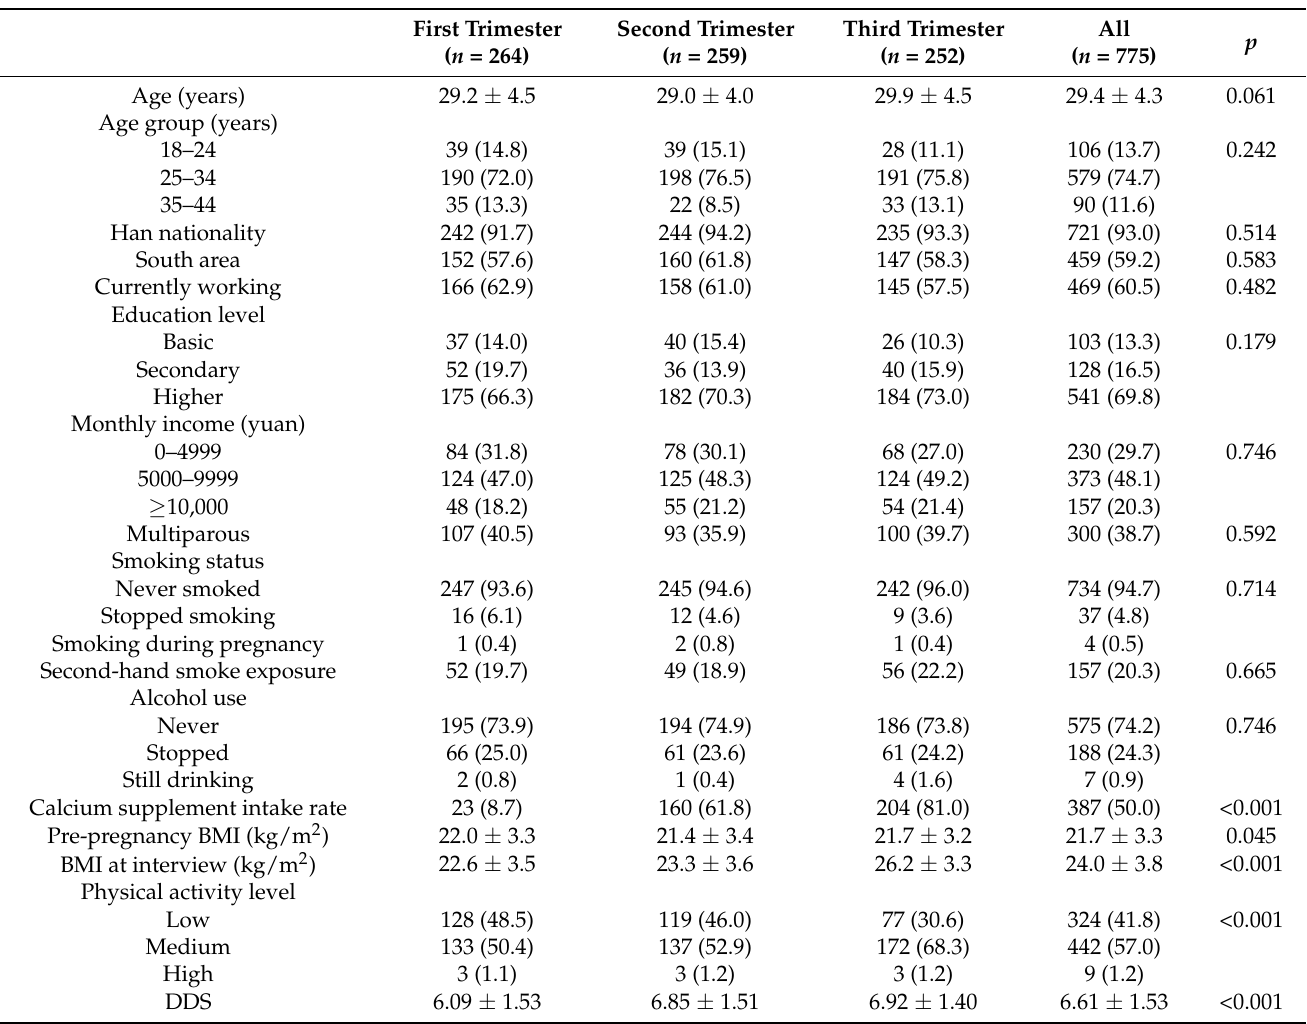
Table 1. Sociodemographic characteristics of women in the different trimesters a .